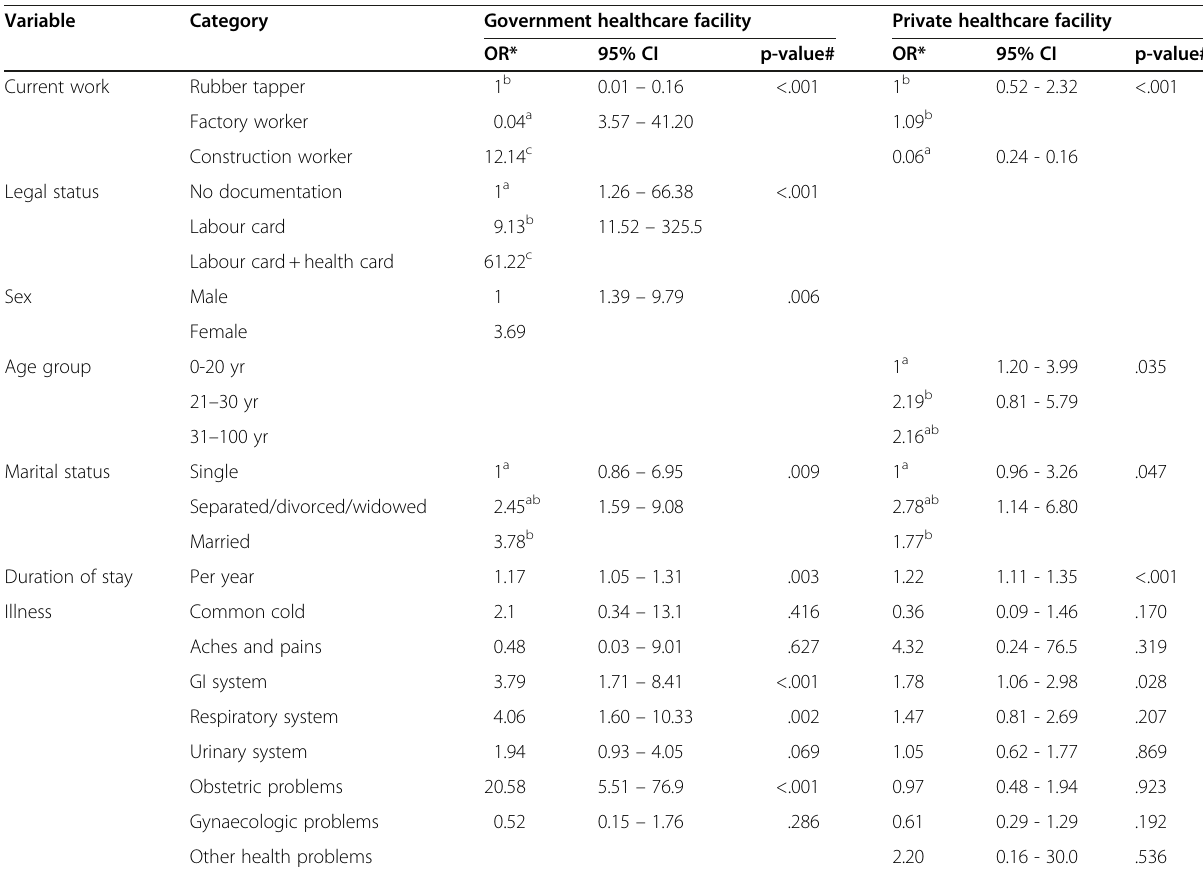
Table 4 Mixed effects logistic regression model for seeking healthcare at a government and private healthcare